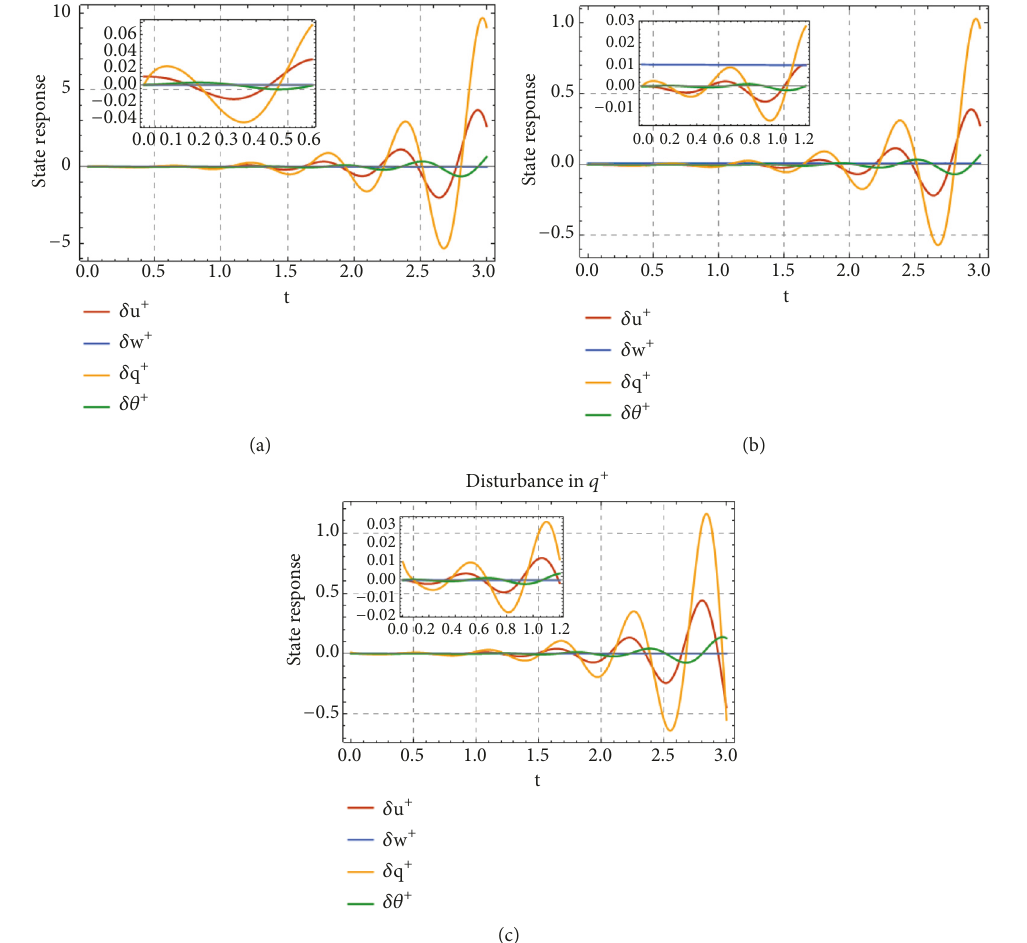
(Figure 2(b)) lags by (2.03𝑟𝑎𝑑)/(10.8𝑟𝑎𝑑/𝑠) = 0.18𝑠 ≈ 0.15